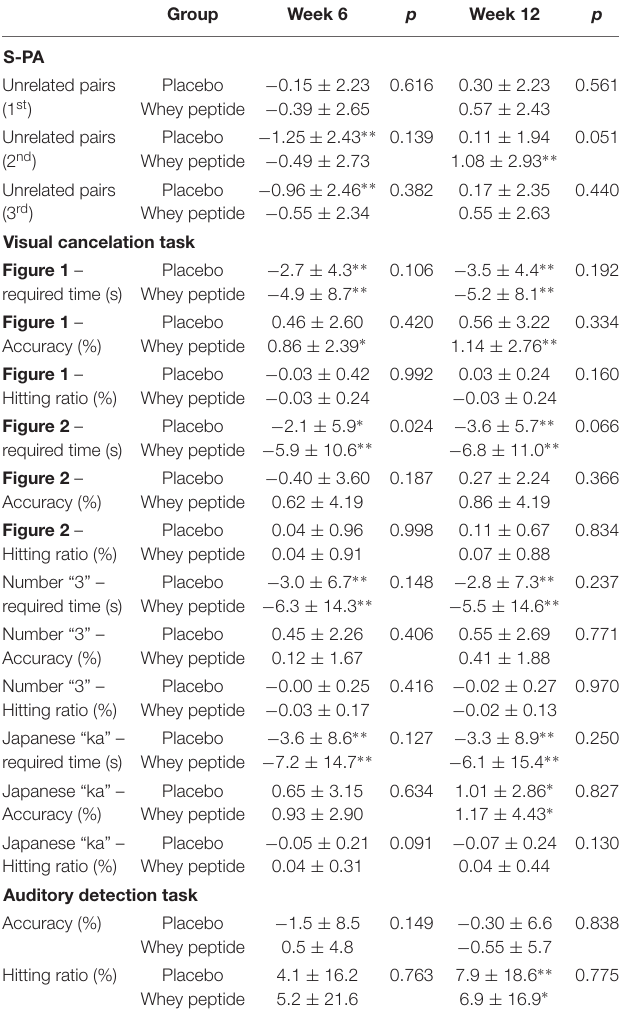
TABLE 3 | Changes in standard verbal paired-associate learning (S-PA) and clinical assessment for attention (CAT) tests.